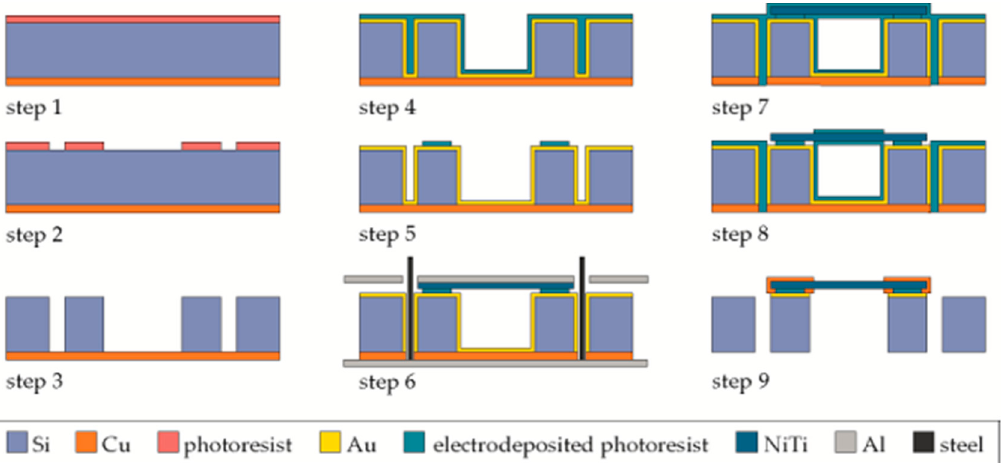
Figure 3. Schematic illustration of the fabrication process: Steps 1–3 show the deposition of a backside copper membrane for stabilization and the dry etching of the gripper outlines. In step 4, the wafer is coated with gold and photoresist, which is used in step 6 for a temporary connection of grippers and SMA actuators. In steps 7 and 8, the wafer is coated with resist again and prepared for the final fixing of wafer and actuator mesh by galvanic